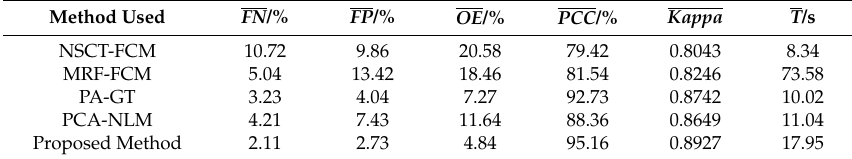
Table 2. Results of different algorithms for detecting the average change of SAR remote sensing